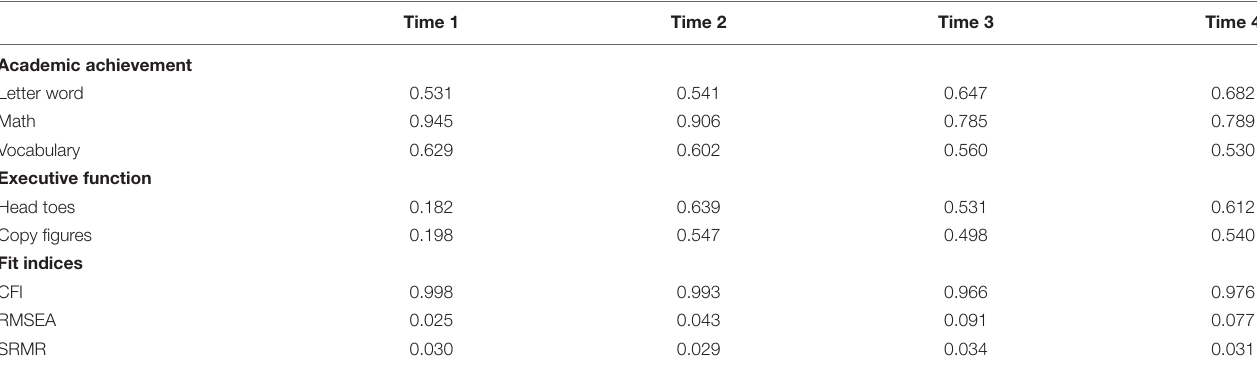
TABLE A1 | Factor loadings and fit indices for academic achievement and executive function.